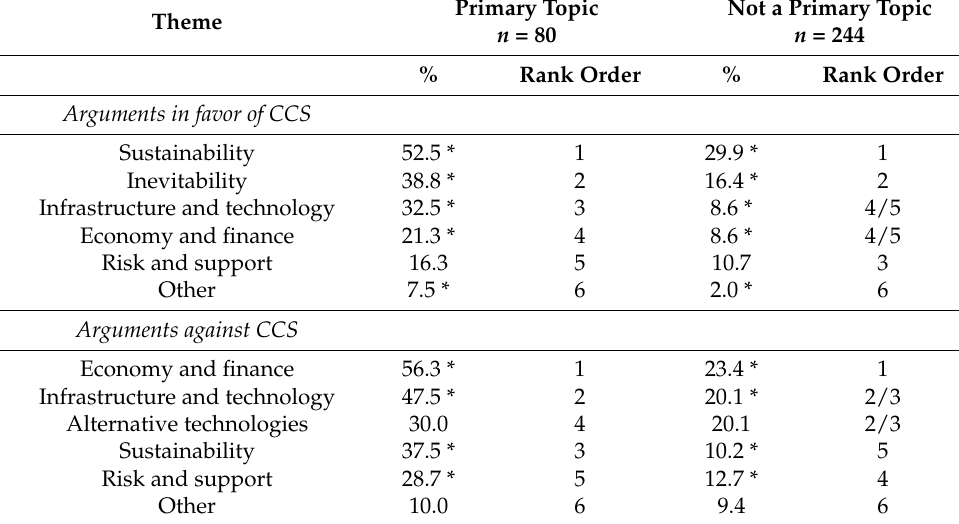
Table 4. Arguments in favor of and against CCS: Themes and the proportion of articles that use at least one argument within each theme as a function of whether CCS is the primary topic in the articles. Primary Topic Not a Primary Topic Theme n = 80 n = 244 % Rank Order % Rank